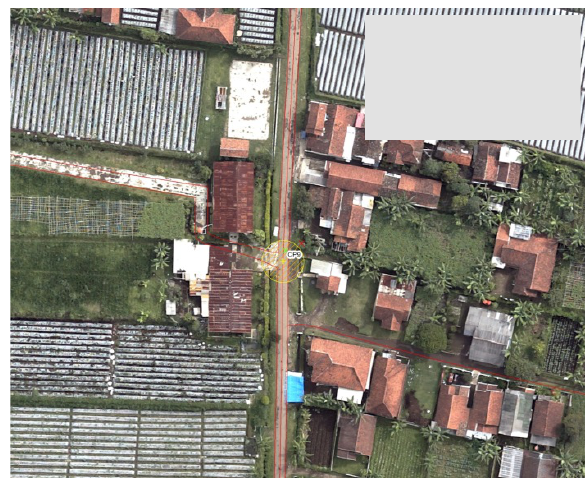
Figure 8. Planimetric Accuracy